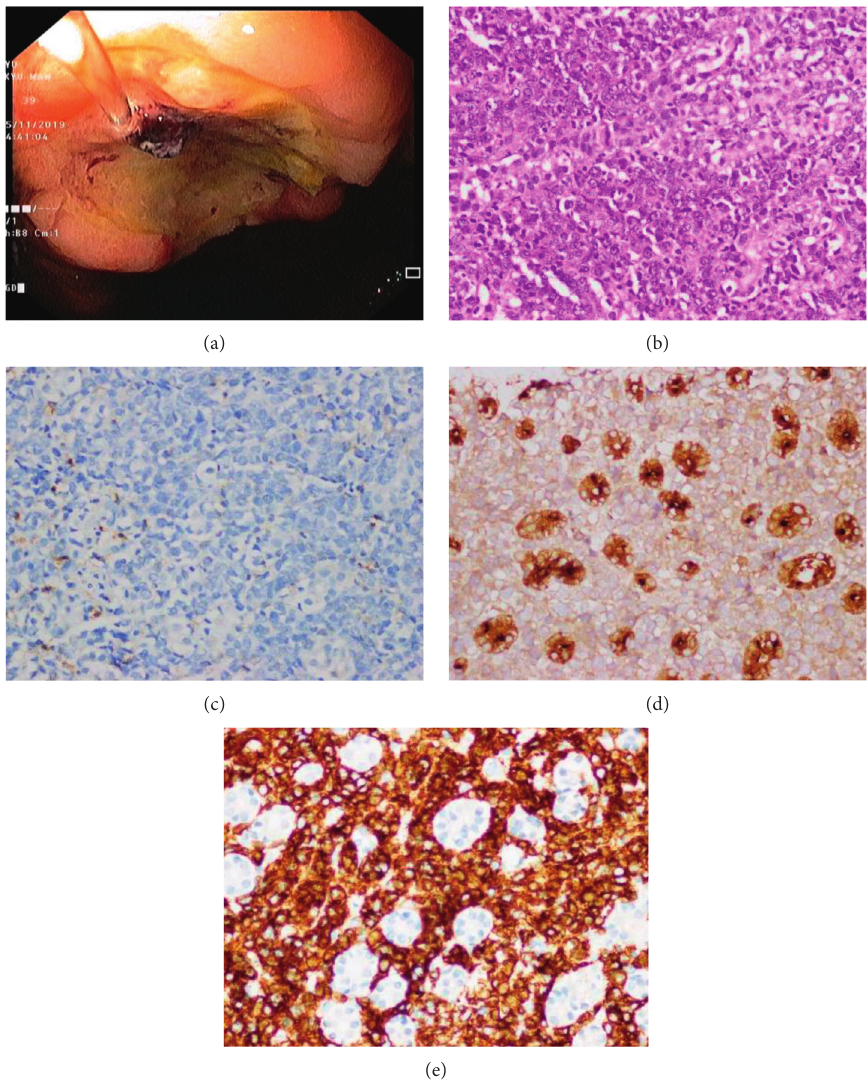
Figure 5: Gastroscopic biopsies and IHC staining. (a) A large gastric ulcer (Forrest IIa) at greater curvature of body of the stomach. (b) Diffuse sheets of atypical large lymphoid cells having vesicular nuclei, prominent nucleoli, and moderate eosinophilic cytoplasm. They are spilling into gastric epithelial cells (IEL, intraepithelial lymphoid cells). Mitoses are occasionally seen (H and E staining; magnification, x40). (c) LCA (leucocyte common antigen, CD 45) negative in tumor cells (IHC x40). (d) EMA (epithelial membrane antigen) negative in tumor cells and positive only in residual gastric glands (IHC x40). (e) CD 20 strongly positive in lesional large lymphoid cells and negative in gastric epithelial cells (IHC staining; magnification,